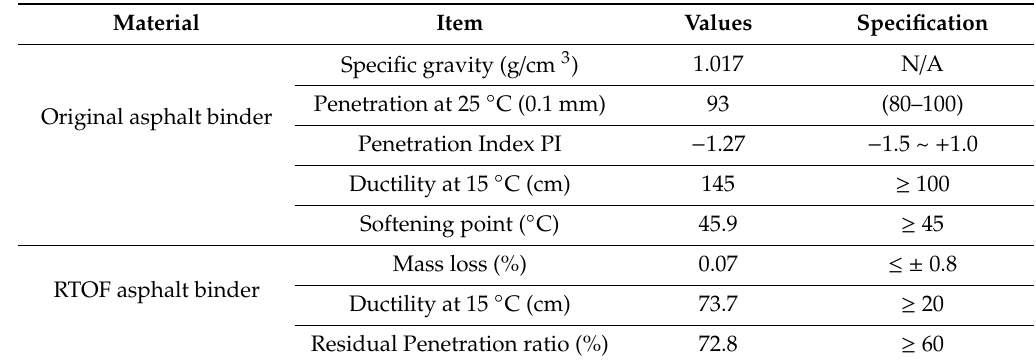
Table 4. Basic Properties of lignin fiber.